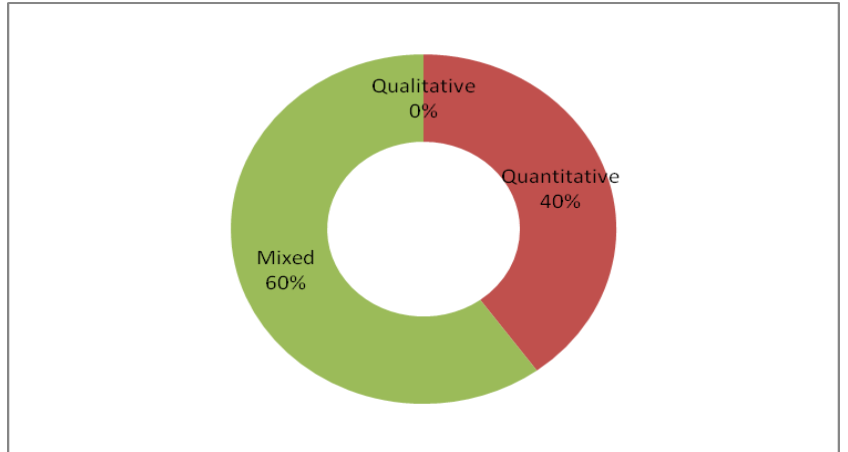
Figure 2 . Percentage of research